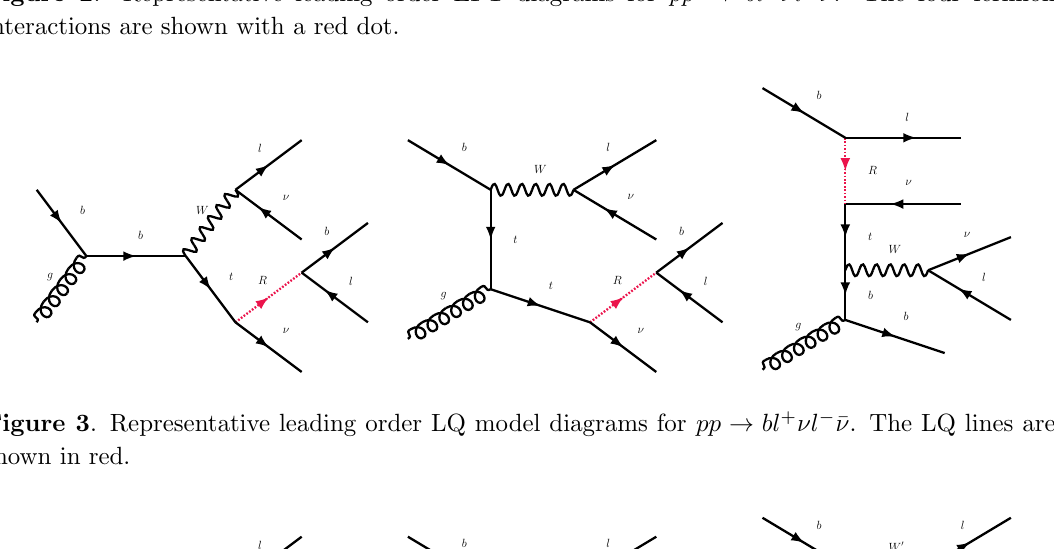
bl + (cid:23)l (cid:0) (cid:22) (cid:23) . The four fermion !